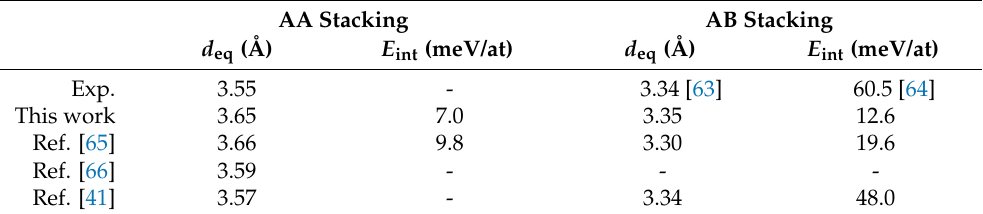
Table 3. Equilibrium interlayer distances ( d eq ) and interlayer interaction energies ( E int ) for AB-BLG and AA-BLG.